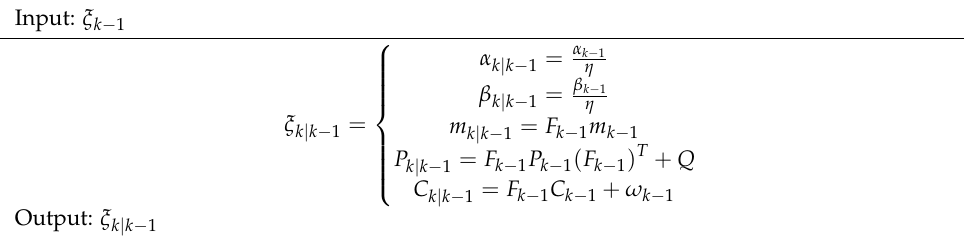
Table 1. Updated GGS parameters of a single extended target. Table 2. Predicted GGS parameters of a single extended